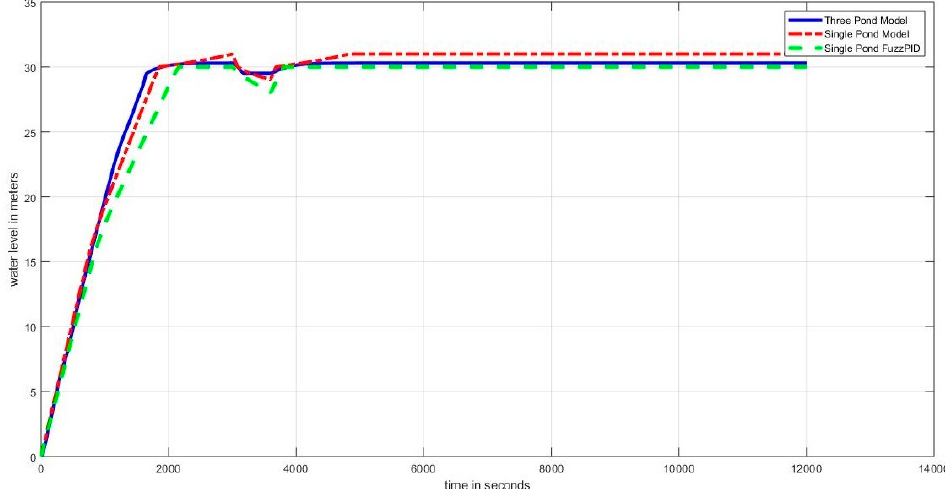
Figure 31. Comparison of the traditional (Fuzzy, FuzzyPID) system with the proposed system (negative surge).